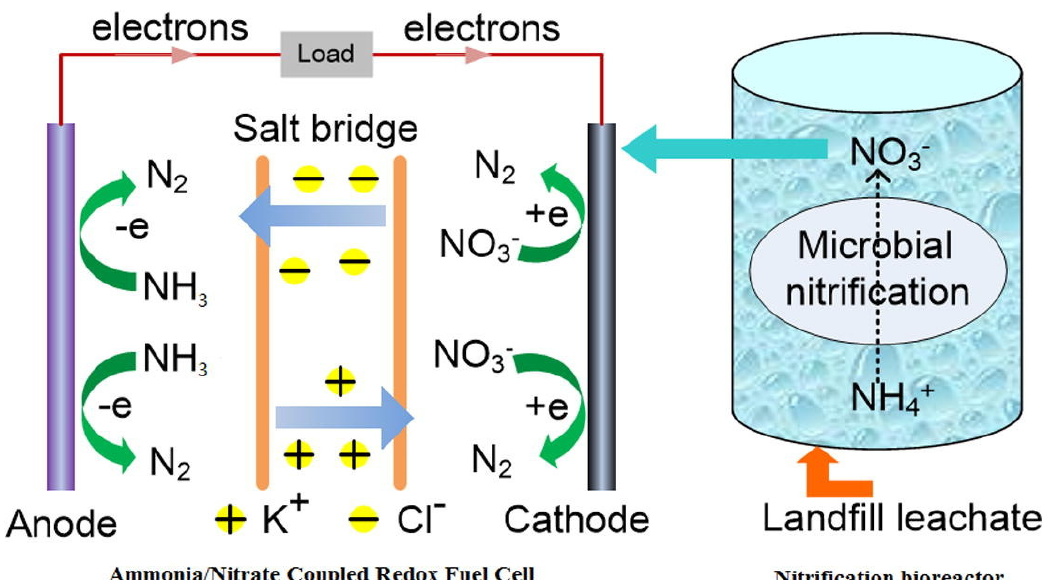
Figure 3. Schematic diagram of N H 3 −N O −